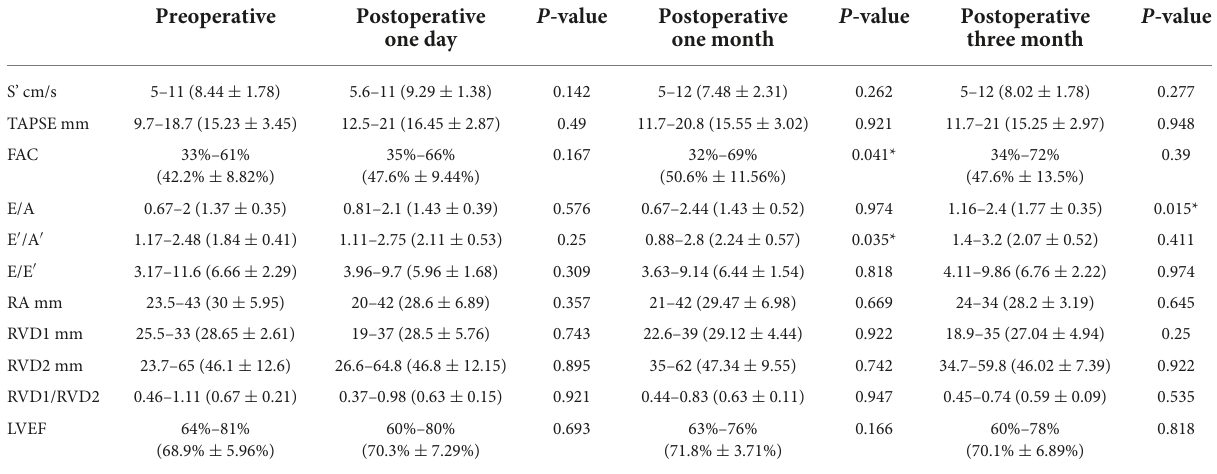
TABLE 6 Echocardiographic parameters about right and left ventricular